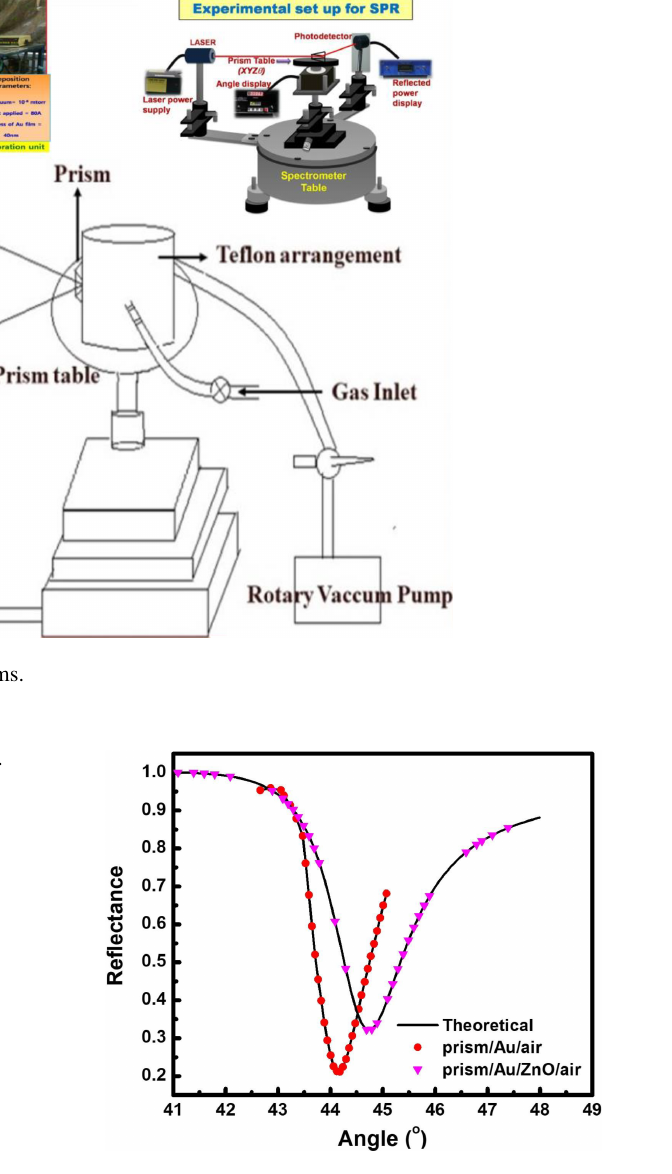
Figure 2. SPR reflectance curve for prism / Au / air and prism / Au / ZnO / air systems at 633nm excitation